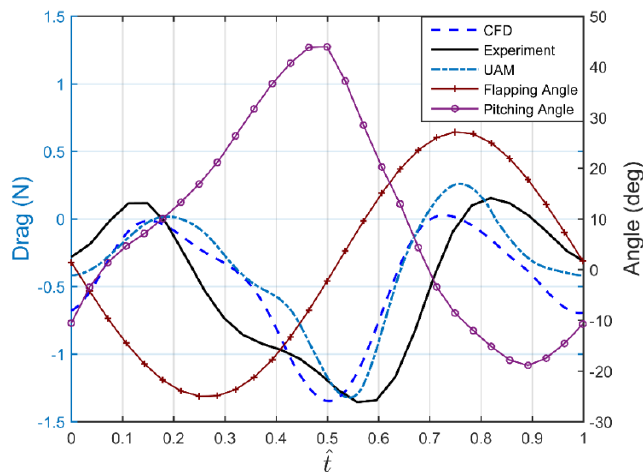
Figure 14. Flapping motion and drag forces by UAM, CFD and experiment (drag force obtained in experiments refers to the net horizontal force).